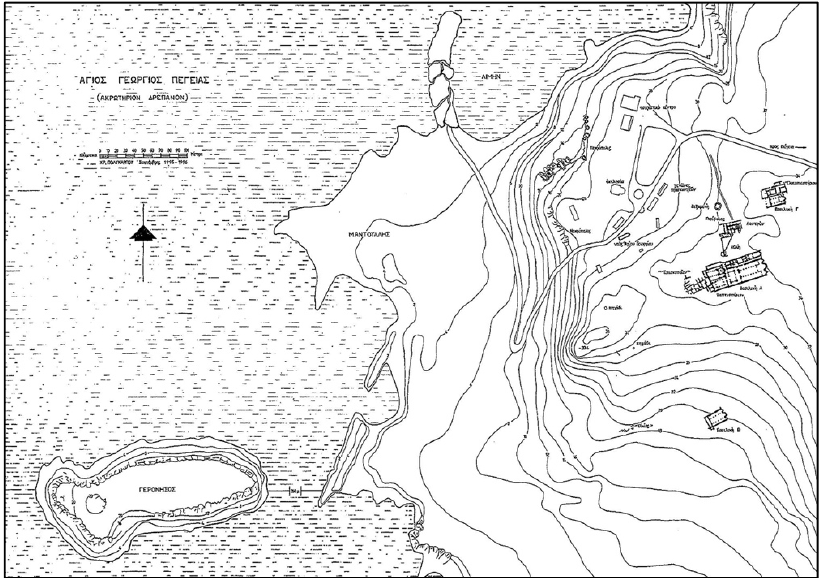
Figure 4. Plan of Agios Georgios, Pegeia (Raptis and Vassiliadou 2005, p. 200, courtesy of the Greek Archaeological Mission at Agios Georgios Pegeia’s wealth, Constantinopolitan influence, and relative safety from attacks all